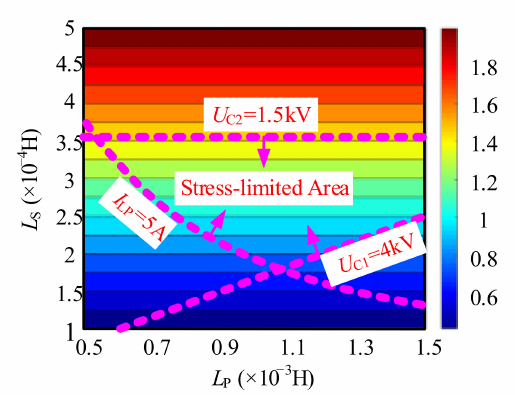
Figure 7. Changes of U C1 with primary and secondary side self-inductance before and after misalign- ment. ( a ) Alignment; ( b ) Offset to farthest distance.